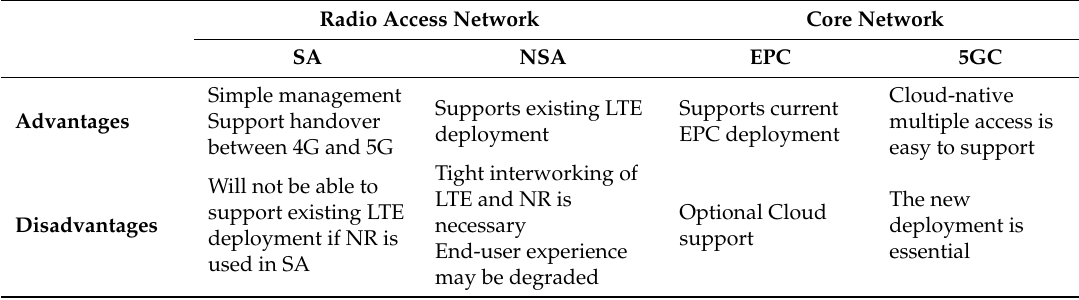
Table 5. Contrast of core network and 5G RAN [51]. SA, standalone; NSA, non-standalone; EPC, evolved packet core; 5GC, 5G core; LTE, long-term evolution; NR, new